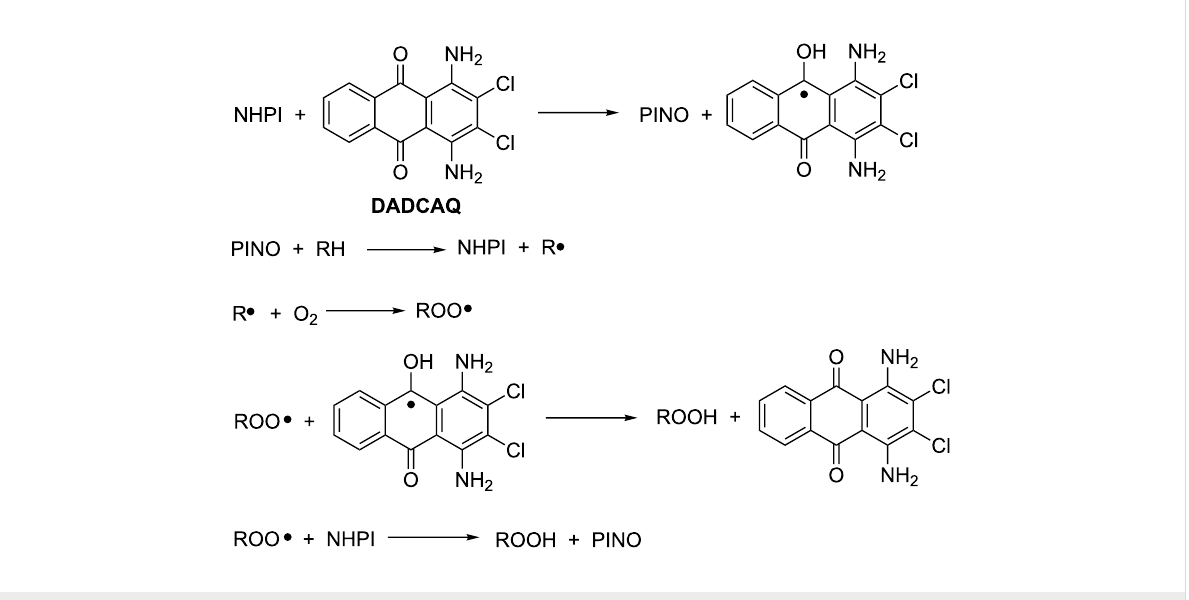
Scheme 12: DADCAQ/NHPI-mediated aerobic oxidation mechanism.